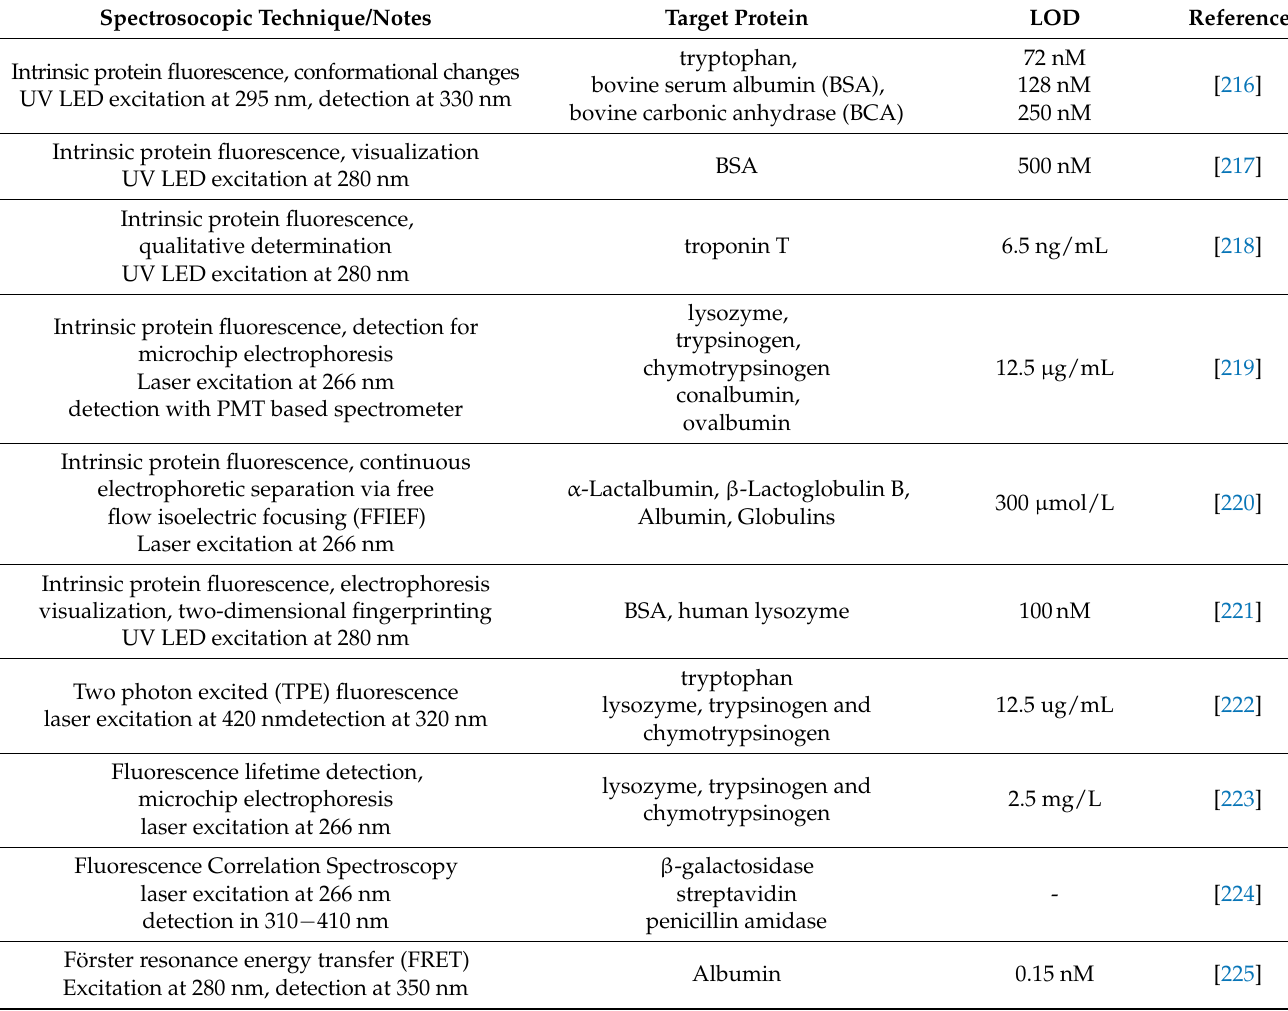
Table 5. Application of label-free fluorescence for detection of proteins in microfluidic devices. Spectrosocopic